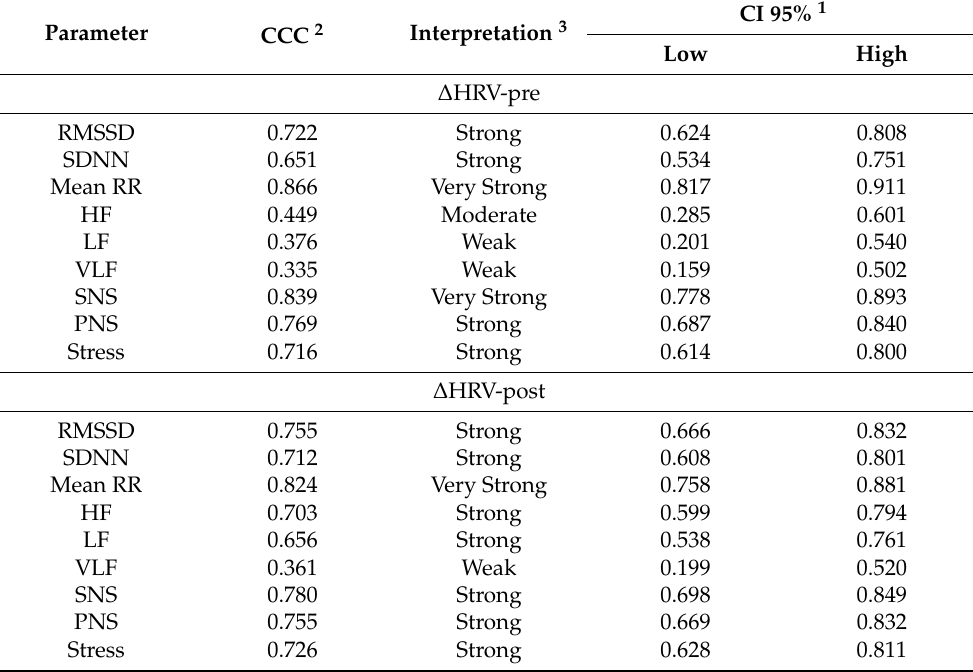
Table 3. Lin’s concordance correlation coefficients evaluate the agreement between analogous HRV measurements. Parameter CCC